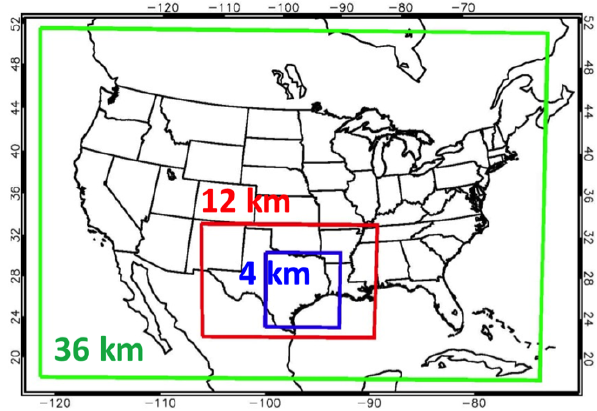
Figure 4. 36, 12 and 4km CMAQ modeling